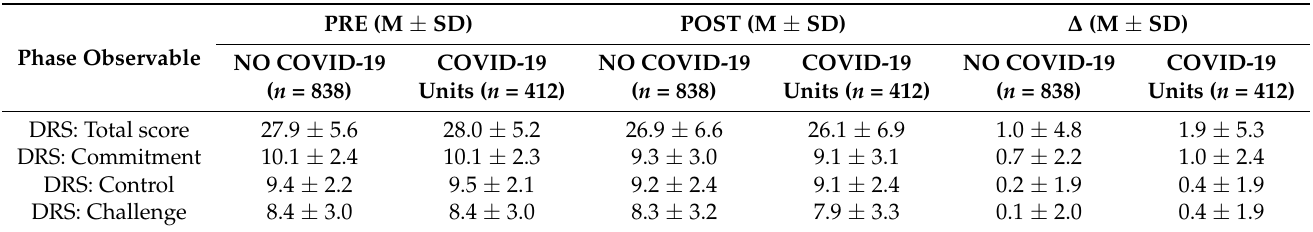
Table 4. DRS total, commitment, control and challenge scores reported as mean (M) and standard deviation (SD) for the nurses taking care of COVID-19 patients and those who did not.